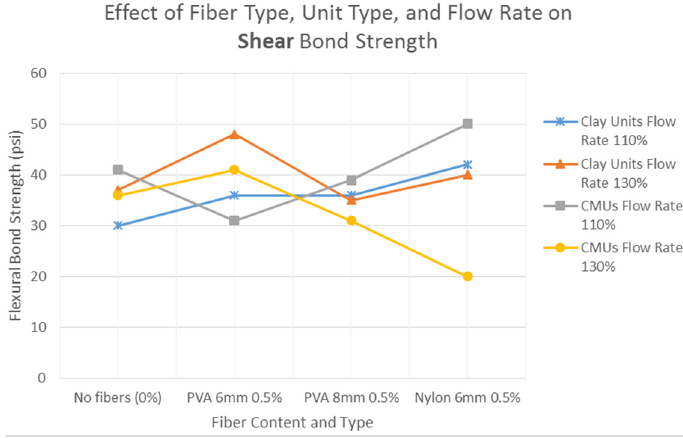
Figure 6. Effect of fiber type, unit type, and flow rate on flexural bond strength.